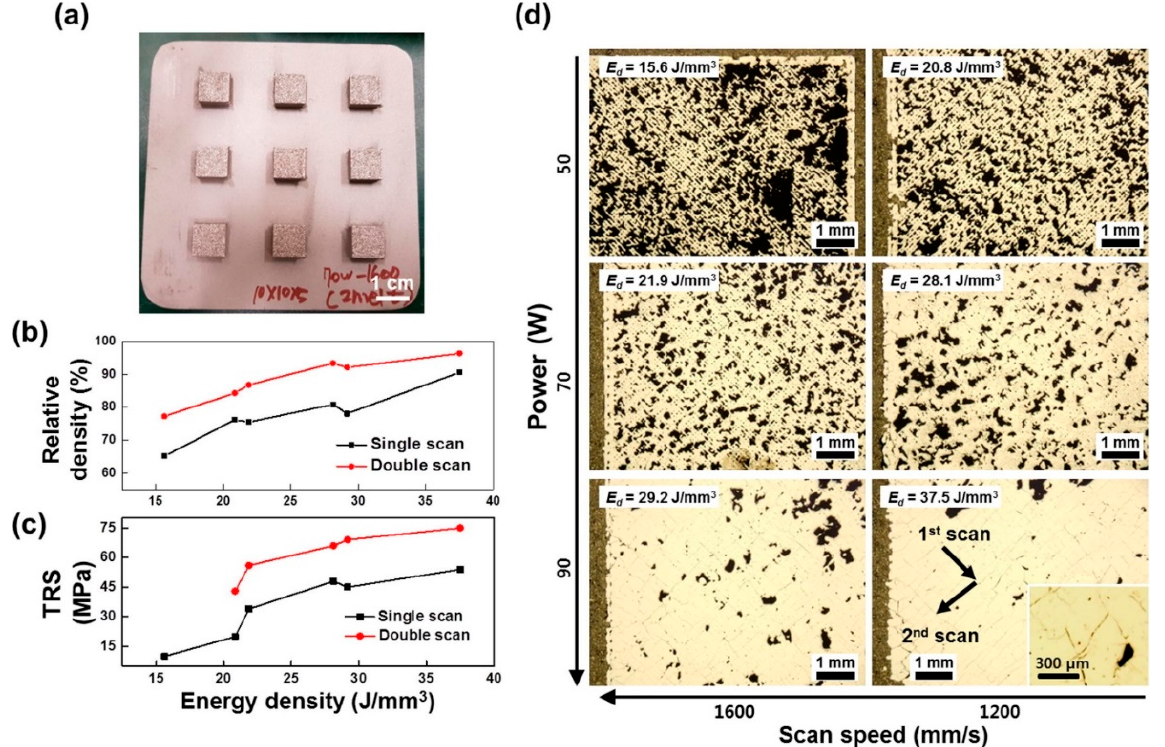
Figure 12. The graph of ( a ) macroscopic photograph of 3D-printed Fe 73.7 Si 11 B 11 C 2 Cr 2.28 alloys, ( b ) relative density and ( c ) transverse rupture strength (TRS) versus laser energy density and ( d ) optic microscope images of double-scanned alloys (reprinted with the permission from [75], Elsevier, 2020).